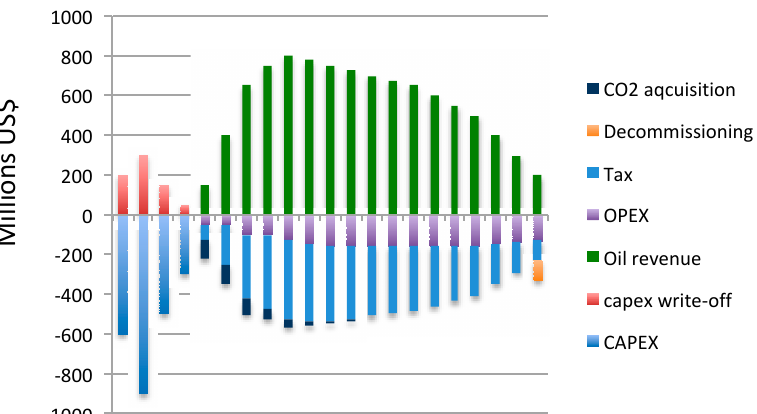
Figure 3. Example of possible cash flow in an offshore CO 2 -EOR project. All numbers are fictitious, but the presentation form is based on examples in References [5] and [10]. In reality, more factors, such as deferred commissioning, will be included.